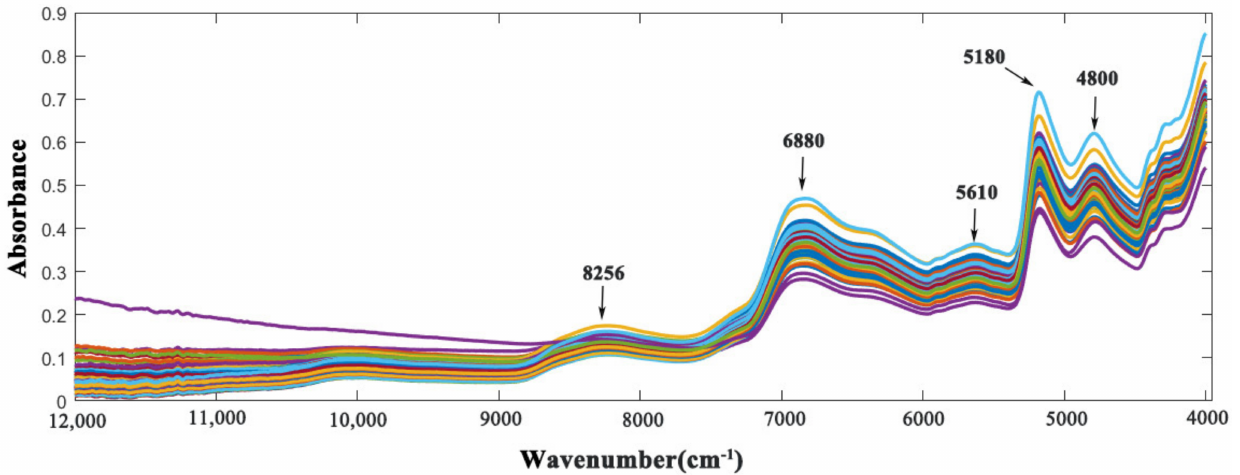
Figure 2. NIR spectra of the 138 PC samples without